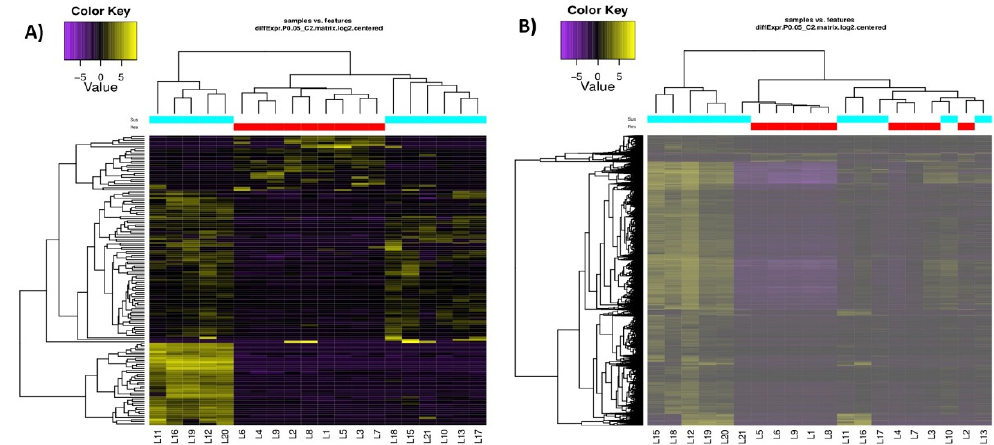
Figure 3. Heat maps of the expression pattern of differentially expressed genes by using ( A ) 141 reference and ( B ) 8680 de novo assemblies. Red and cyan represent the resistant and susceptible lines, respectively.